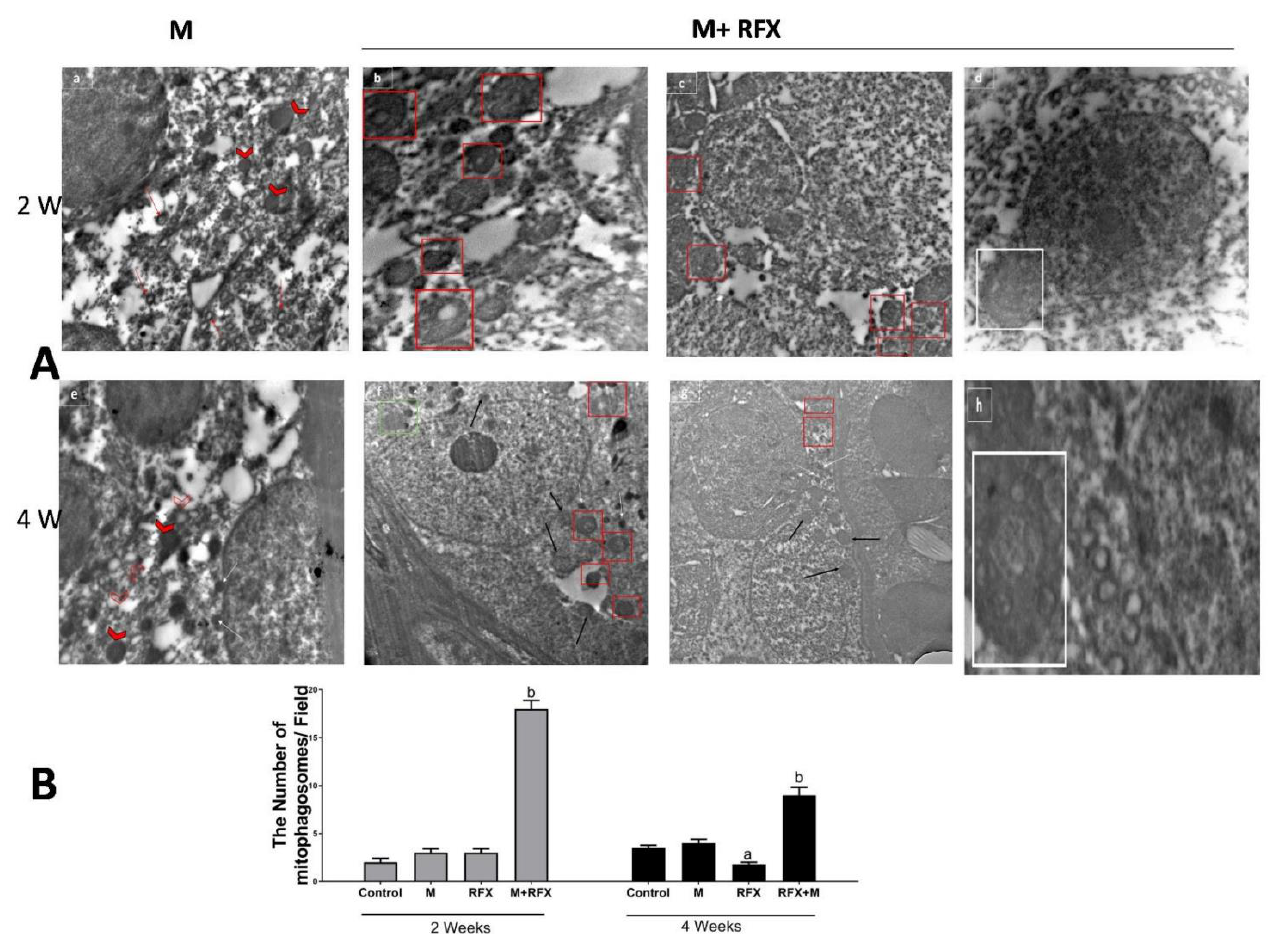
Figure 12. ( A ) Electron microscopic analysis of mitophagy in the malathion group and RFX treated groups. ( a ): Selected micrograph of rats exposed to malathion over two weeks clearly show the absence of autophagic vesicles, meanwhile some mitochondria exhibit a marked swelling (arrowhead); the rest of mitochondria are evidently impaired, with an absent double membrane; distorted cristae; and a noticeable reduction in electron-dense granules in the intramitochondrial matrix (red arrow). ( b – d ): Selected micrograph for rats treated with RFX for two weeks after exposure to malathion, where in ( b , c ), cells show various degree of damage with an abundance of mitophagosomes (red square), while in ( d ) typical autolysosome-enveloping mitochondria is visible (white square). ( e ): Selected micrograph for rats exposed to malathion for four weeks show diffused cellular damage, where mitochondria are visibly fewer in number and are mostly remnants of mitochondria (empty arrowhead) in addition to the swelling. Lysosomes (while arrow) are not involved in autolysosomes. ( f – h ): Selected micrograph for rats treated with RFX for four weeks after exposure to malathion, where, as seen in ( f , g ), cells exhibit various degree of retrieved vitality with an abundance of normal new intact mitochondria (black arrow), mitophagosomes (red square), lysosomes approximate to mitophagosomes (white arrow), and lysosomes in fusion with mitophagosome (green square), while in ( h ), typical autolysosome-enclosing mitochondria are noticeable (white square). ( B ) Quantification of mitophagosomes. The number of mitophagosomes/field was determined in electron micrographs. Data are expressed as means ± SEM.